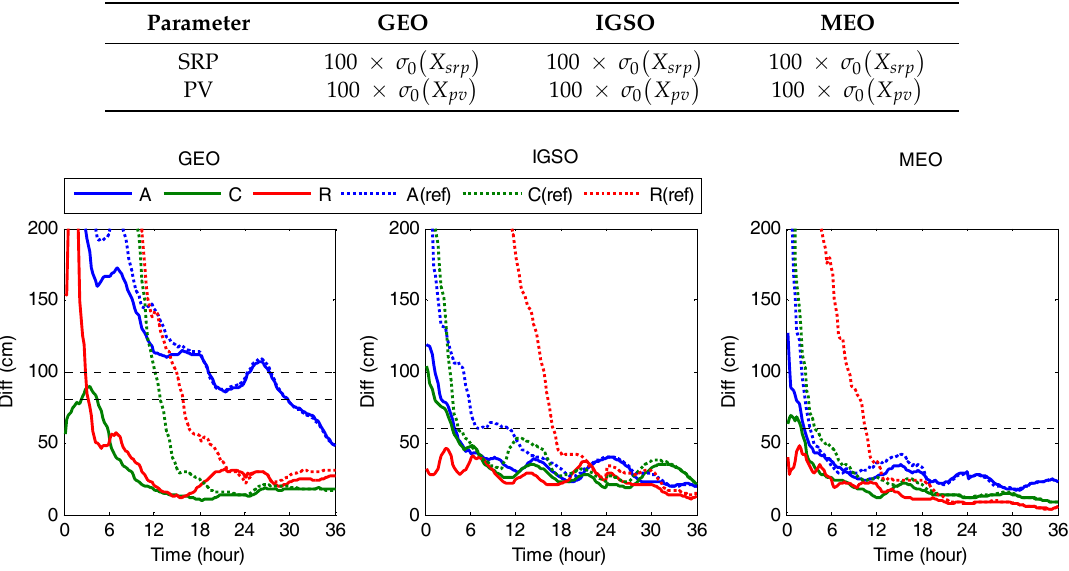
Figure 9. Time series of the average accuracy of the filter orbits with the optimal a prior STD magnitude. The BRDC product is used as the initial orbit. The dotted line represents the accuracy of the REF orbits described in Section 3.1. The horizontal black dotted line represents the convergence criteria for each direction.